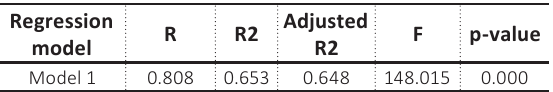
Table 4. Summary of regression model and ANOVA results